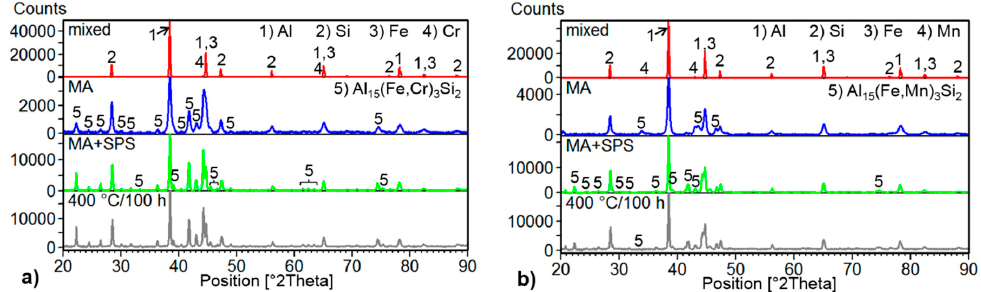
Figure 3. XRD patterns of the: ( a ) Al-20Si-10Fe-6Cr; ( b ) Al-20Si-10Fe-6Mn alloys at different stages of preparation including as mixed pure powders, MA powders, MA + SPS compact samples and MA + SPS compact samples annealed at 400 °C for 100 h. Table 1. Summary of the results of XRD analysis of the Al (111) peak in the investigated alloys at different stages of preparation (2 θ , diffraction angle; FWHM, Full Width at Half Maximum).